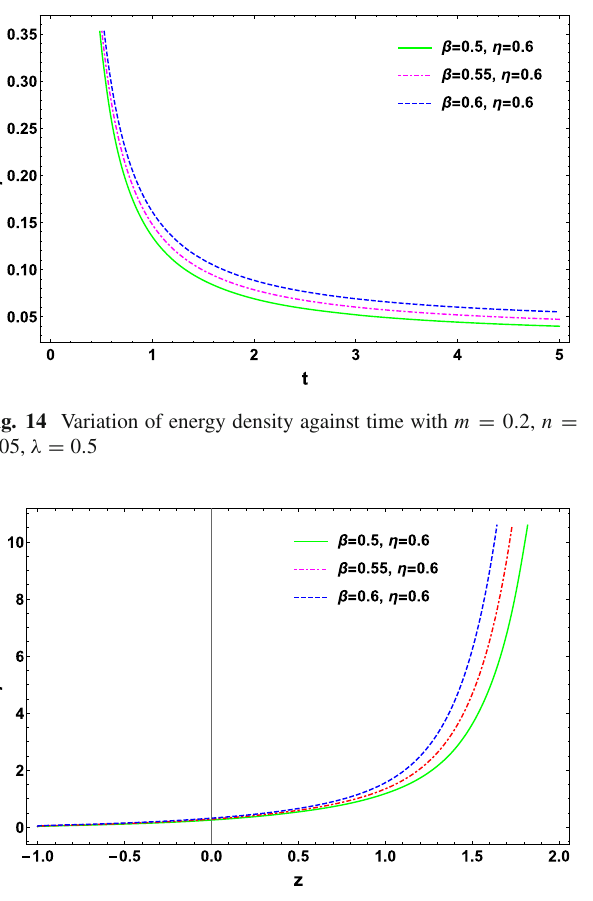
Fig. 15 Variation of energy density against z with m = 0 . 2, n = 0 . 05, λ = 0 . 5